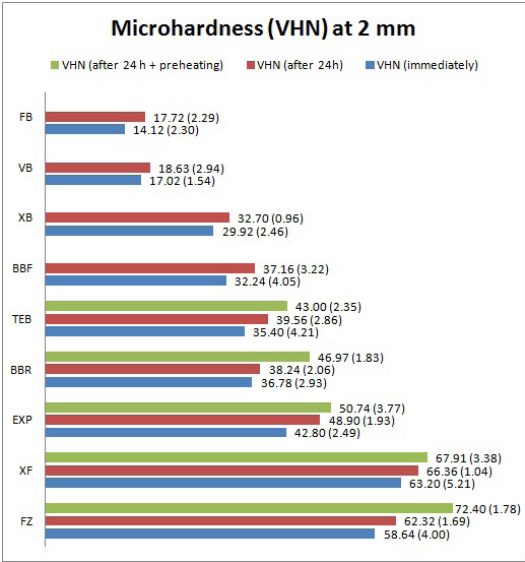
Figure 2. Mean values and standard deviations of microhardness expressed in VHN of all the experimental groups at 2 mm depth.